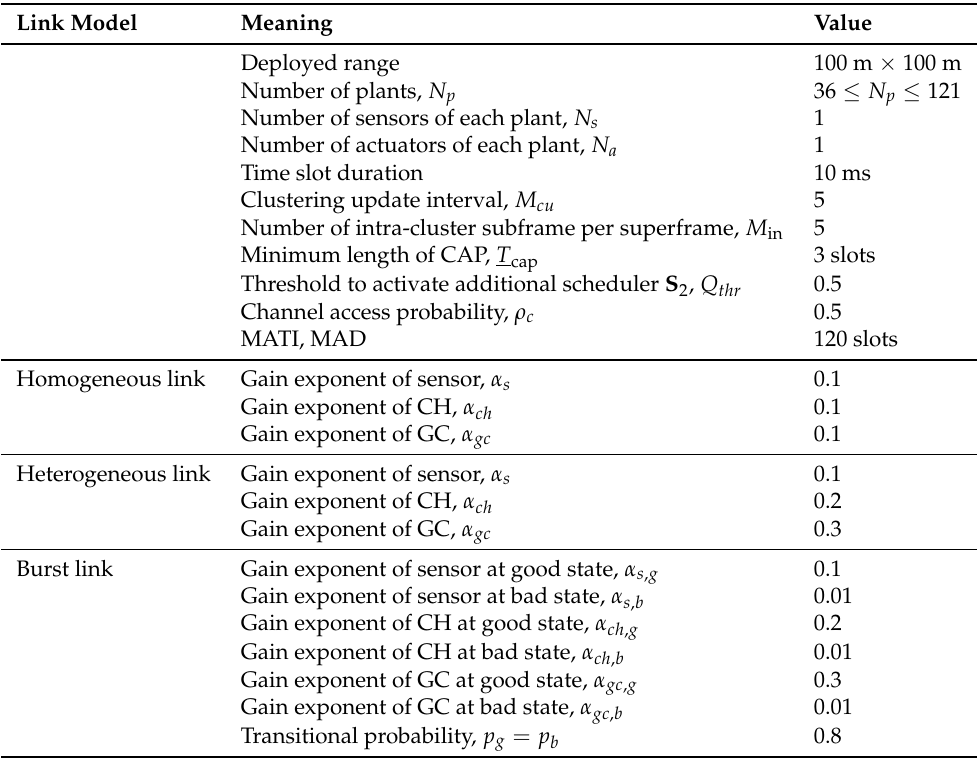
Table 1. Default simulation parameters used in the paper. We consider three different link models, namely, homogeneous, heterogeneous, and burst